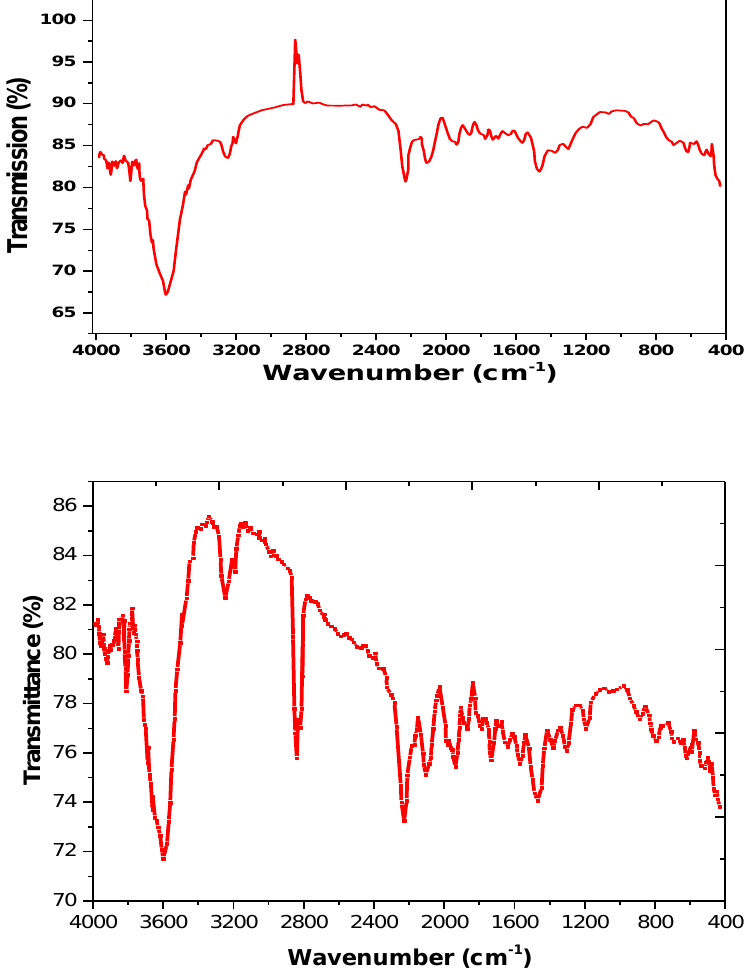
Fig.3: FTIR pattern for pure PCL, and PCL/ZnO nanocomposites at